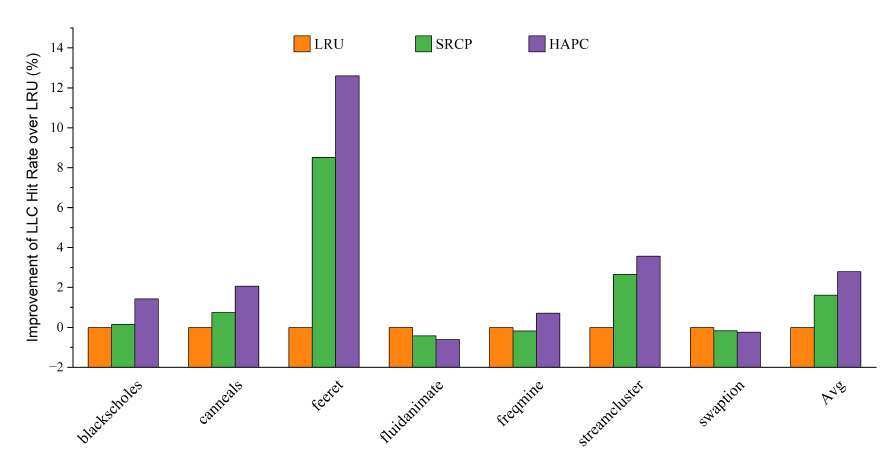
Figure 6. Improvement of hit rate over baseline LRU.